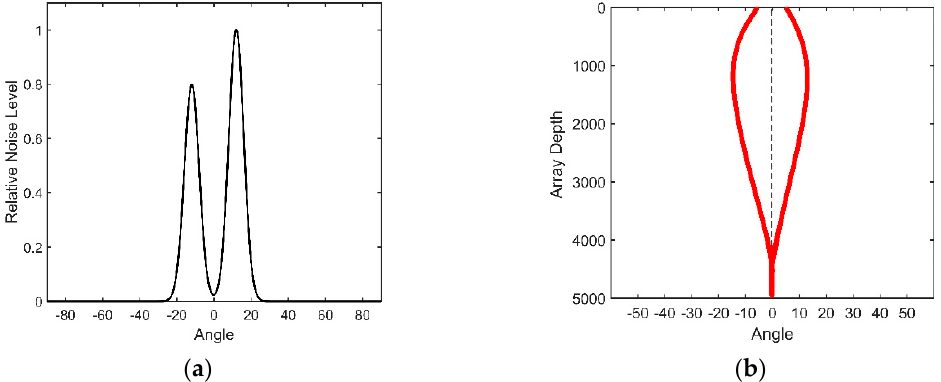
Figure 13. ( a ) Shipping noise directional density at the depth of the DSC; ( b ) Shipping noise directional density for all depths. density for all